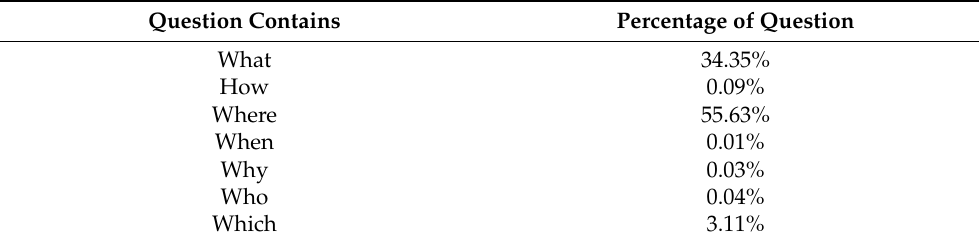
Table 5. The proportion of the questions that exactly contain the specific word in location-related questions in MS